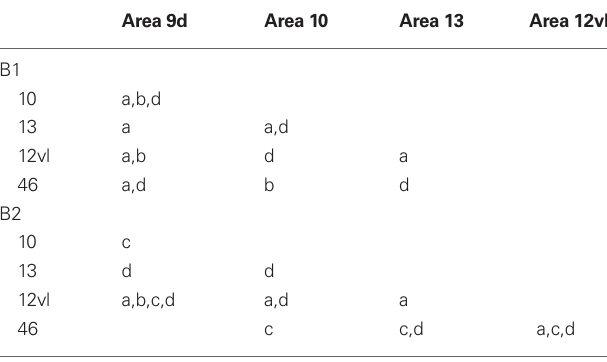
Table 10 | Summary of post hoc pair-wise Scheffe comparisons of morphological parameters of neurons in the gPFC of the baboon.